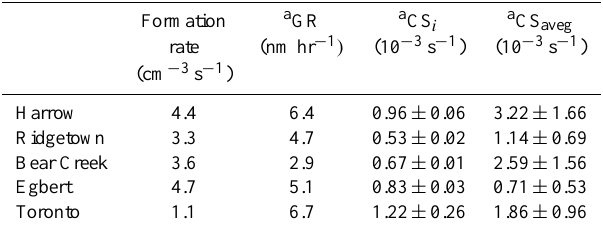
Table 5. Characteristics of nucleation events observed at the five sites on 2 July